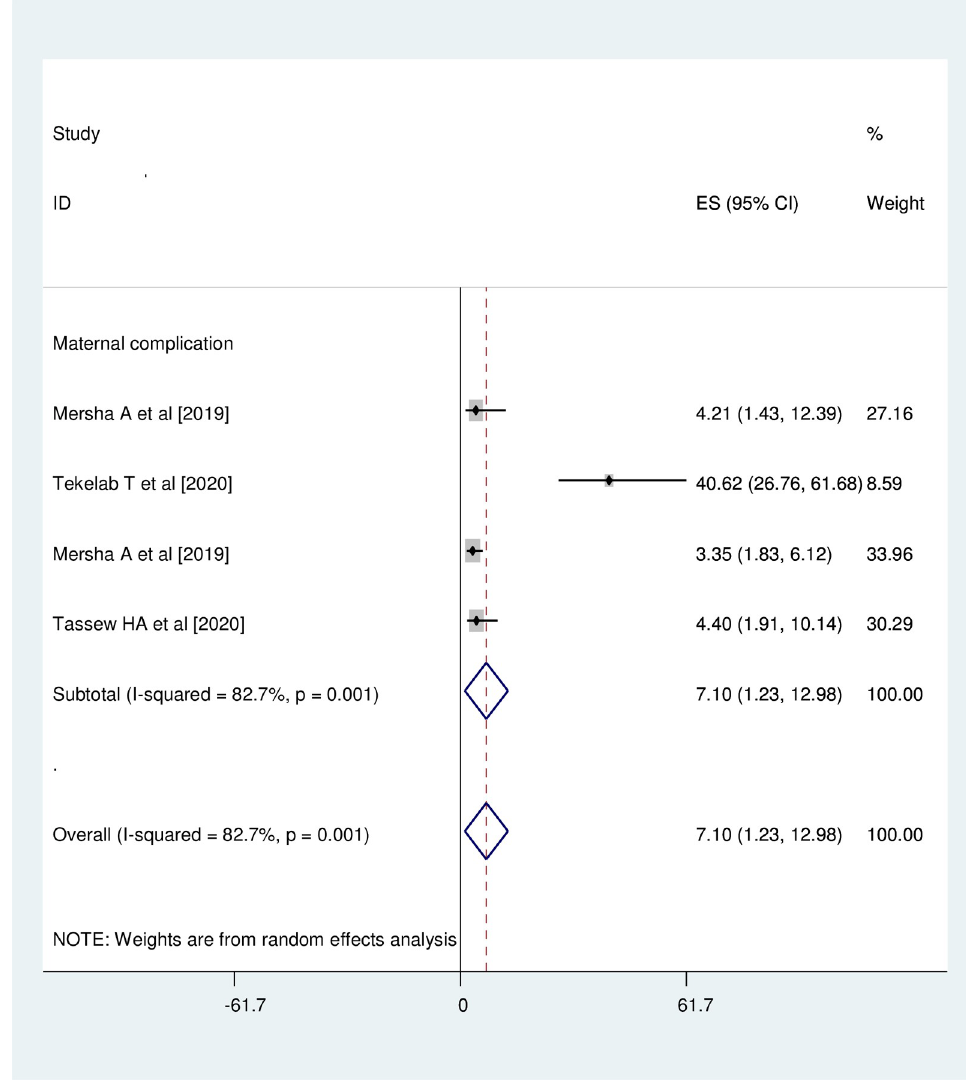
Fig 8. Association between history of maternal medical complication and neonatal near